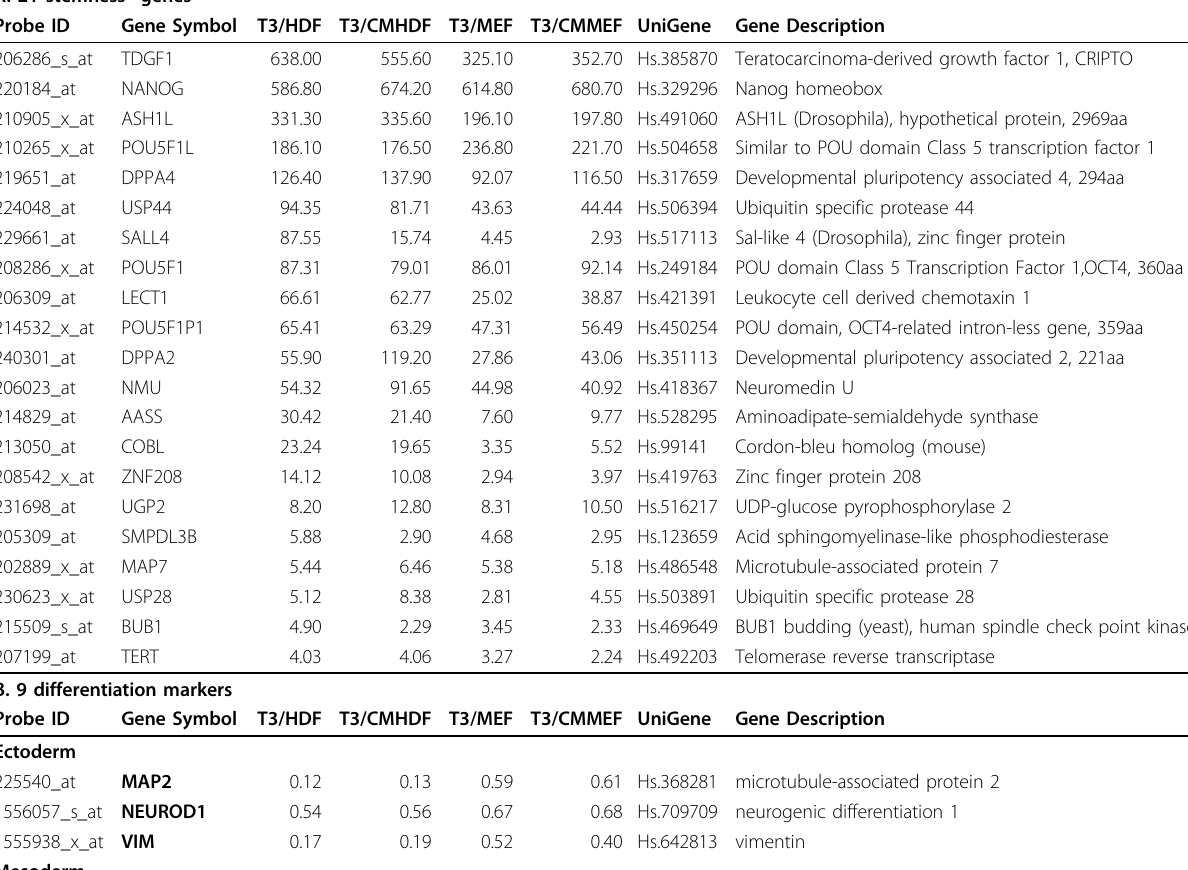
Table 1 The expression levels of “ stemness ” genes and differentiation markers A. 21"stemness ” genes Probe